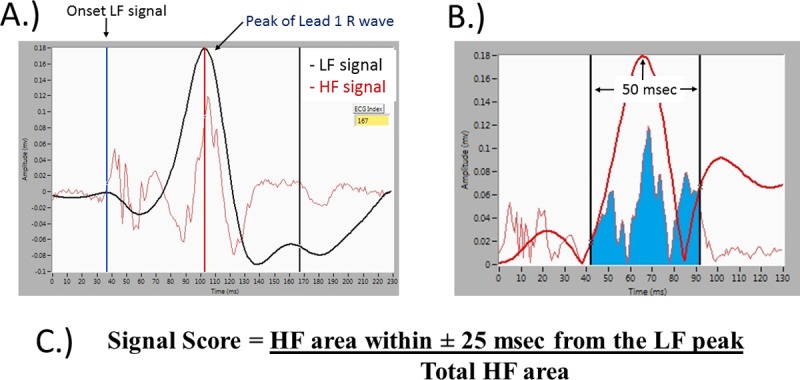
Novel signal analysis composite score (signal score).This figure demonstrates the generation of the composite Signal Score. A.) The high frequency (HF) and low frequency (LF) components of the signal on the distal ablation catheter are filtered and the onset of the LF and peak of the R wave on surface lead I are identified. B.) The area under the curve of the high frequency signal within a window of 50 msec, from 25 msec before to 25 msec after the peak of the LF signal, is calculated as the composite signal score (C.).